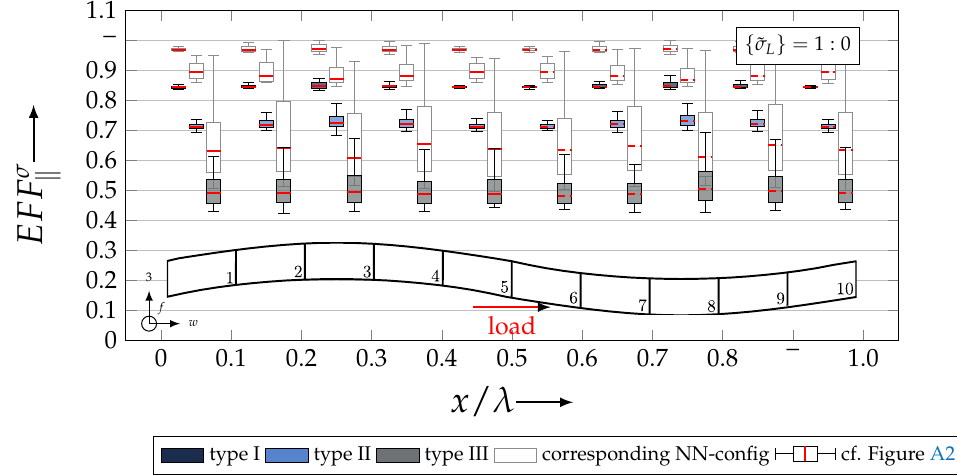
Figure 34. Comparison of EFF σ -distribution for NN and MN configs. for the triggered fracture (cid:107) resistance of the NN config. according to Equation (23) at load ratio { ˜ σ L } = 1:0 in weft direction for considered weft yarn according to Figure